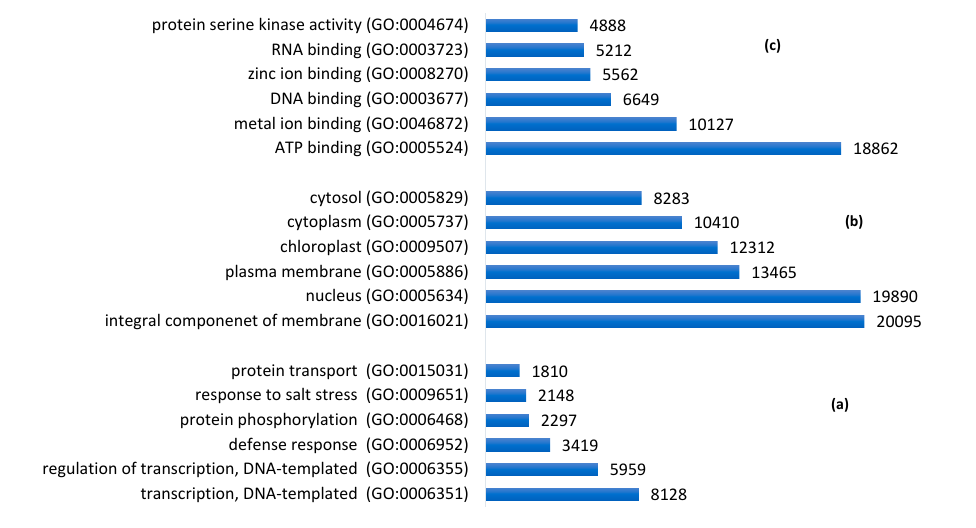
Figure 2. Gene Ontology (GO) classification of A. marmelos transcripts. GO term are divided in three main categories: biological process ( a ), cellular component ( b ), and molecular function ( c ).